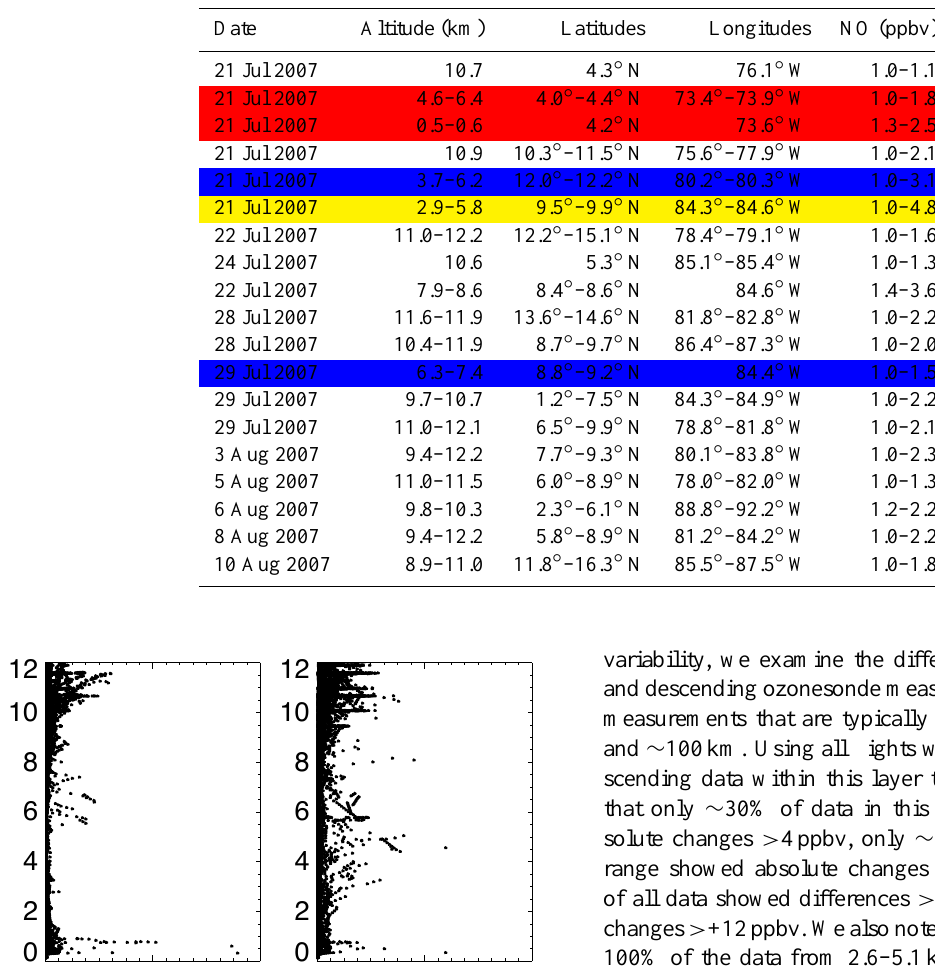
Table 4. Measurements of NO > 1ppbv, > 50km away from Alajuela, Costa Rica airport (10.0 ◦ N, 84.2 ◦ W) from DC-8 flights during TC4. Enhanced NO < 8km are highlighted orange over Columbia, blue over open water, and yellow over the west coast of Costa Rica.